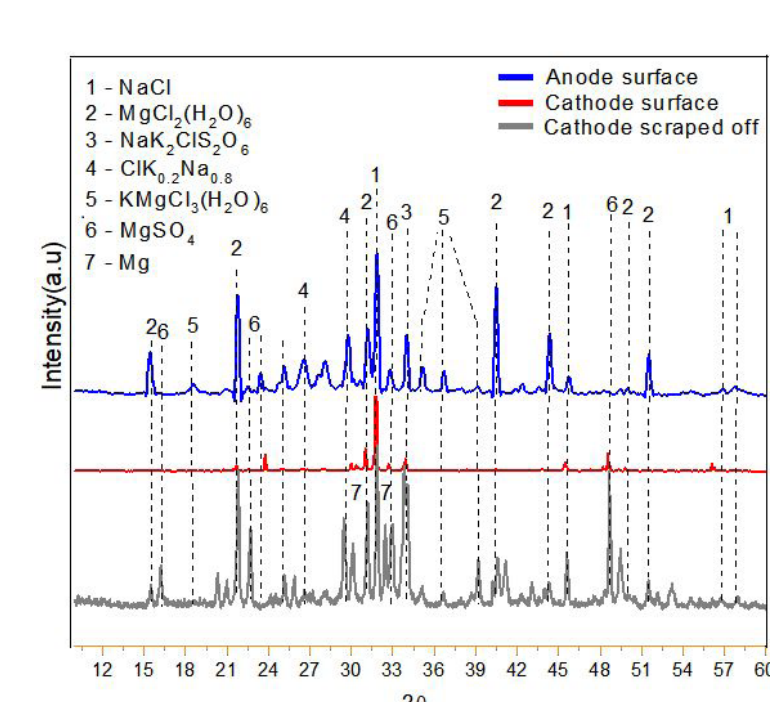
Figure 6. X-Ray Diffractions of filtrated crystals from anode (blue), cathode (red) solutions and solids deposited in the reactor wall and electrode in cathodic configuration